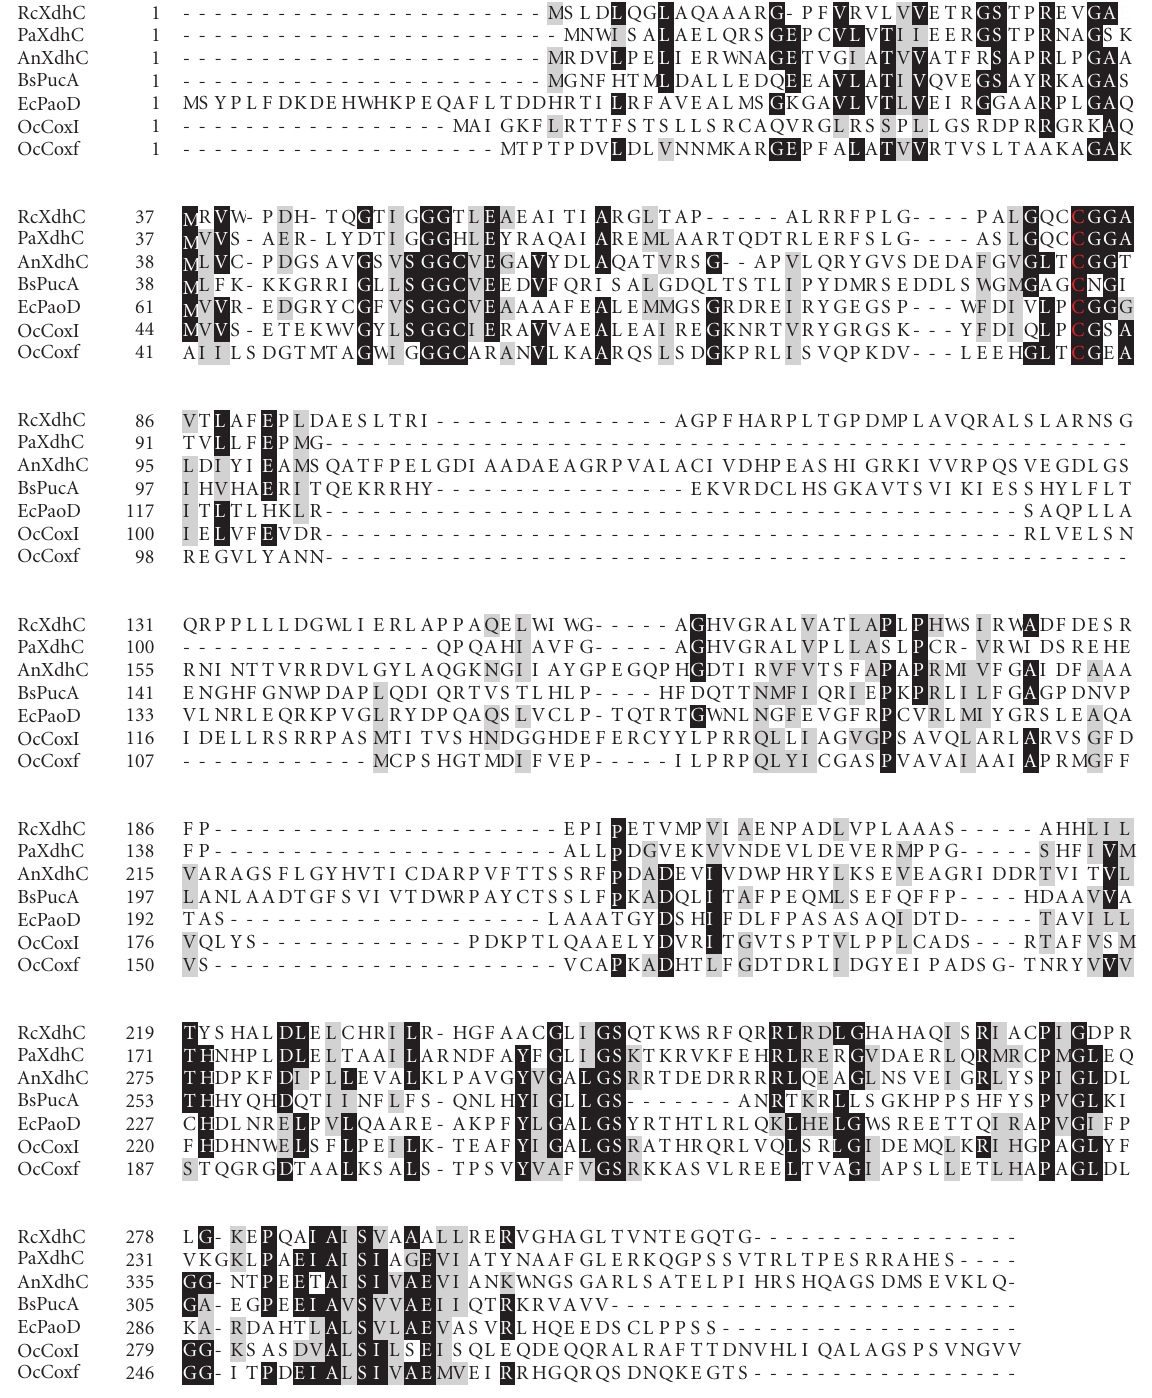
Figure 4: Amino acid sequence alignment of XdhC-like proteins from di ff erent bacteria. Shown is an amino acid sequence alignment of the XdhC-like proteins organized in operon structures (from Figure 1) from R. capsulatus ( Rc XdhC), E. coli ( Ec PaoD), P. aeruginosa ( Pa XdhC), O. carboxidovorans ( Oc CoxF, Oc CoxI), A. nitroguajacolicus ( An XdhC), and B. subtilis ( Bs PucA). A highly conserved cysteine residue present in all XdhC-like proteins is highlighted in red. Identical amino acids are boxed in black, and homologous amino acids are shaded in grey. The amino acid sequence alignment was performed using ClustalW and visualized using